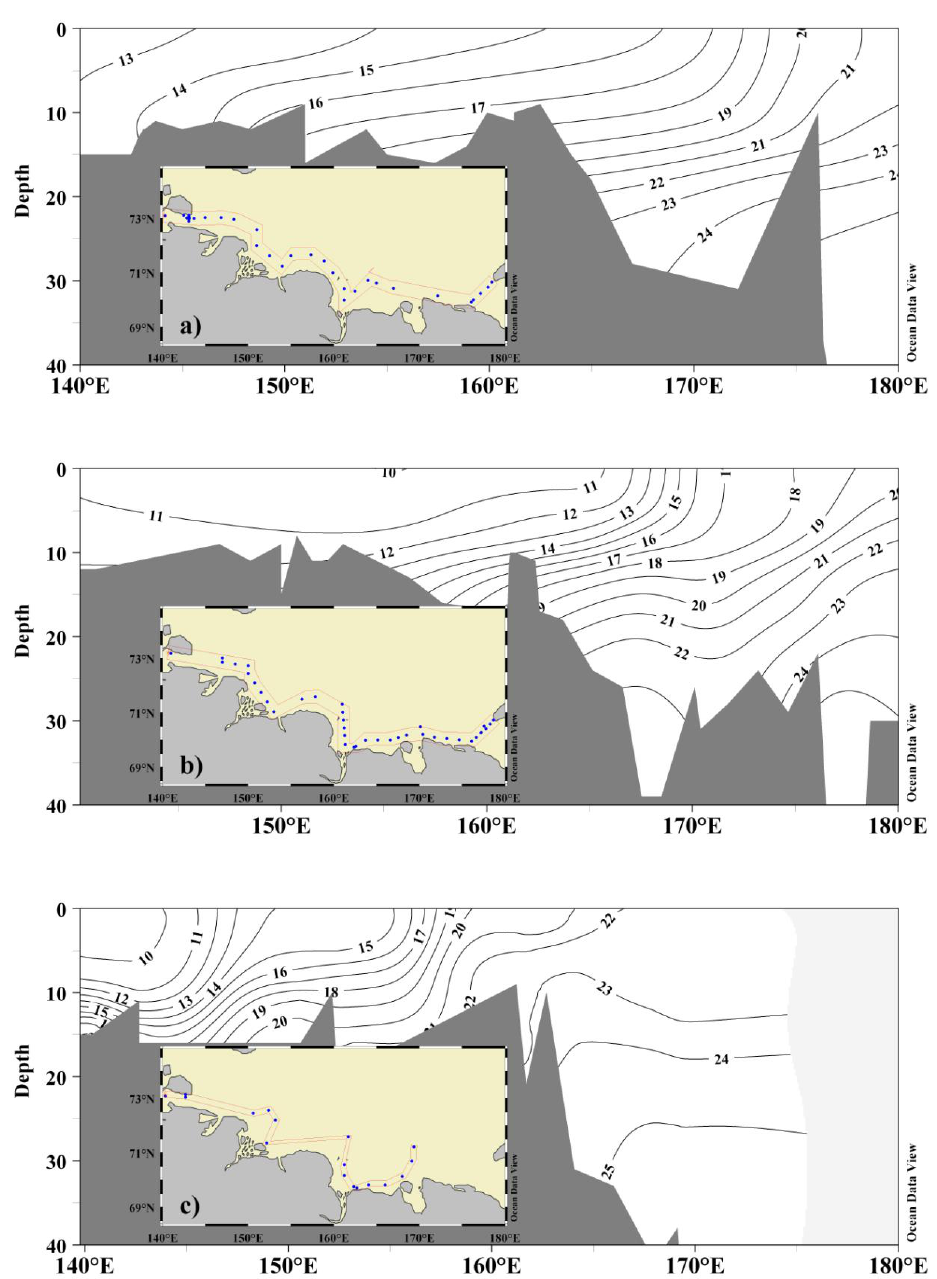
Fig. 6. Profiles of density, expressed as σ = 1000 × (density-1), (kgm − 3 ) on the alongshore transects in September 2003 (a) , 2004 (b) , and 2008 (c)